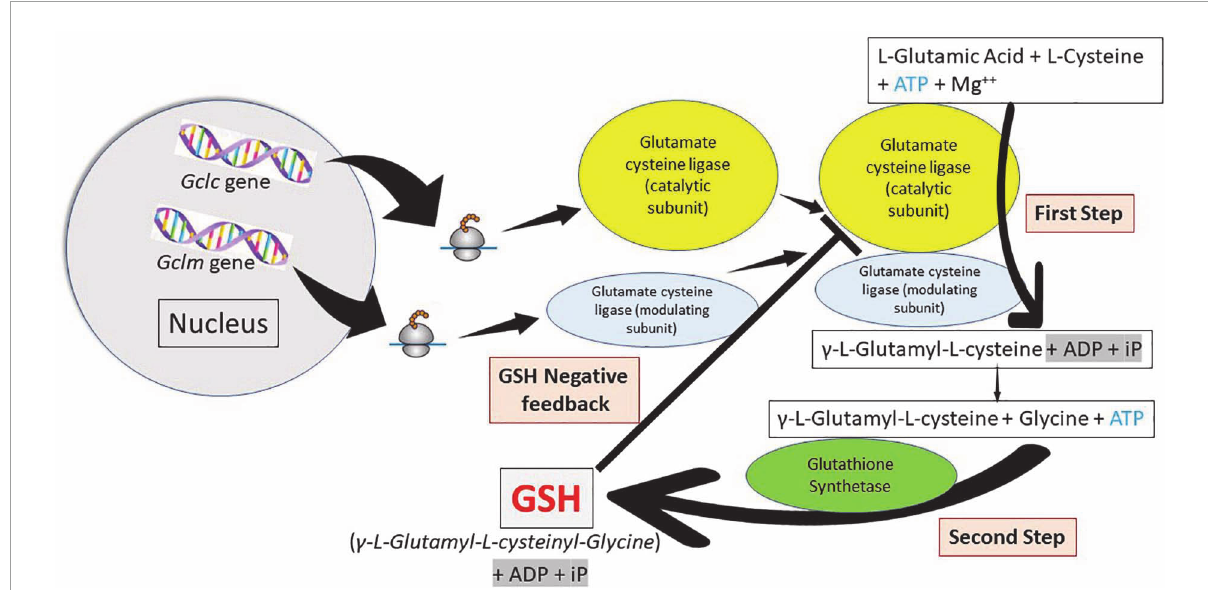
FIGURE3 Glutathione synthesis: A two-step pathway. Homeostasis of cellular glutathione. Synthesis and regulation of the cell concentrations. Glutamate cysteine ligase ( γ -glutamyl cysteine synthetase) constitute the first step in the synthesis of glutathione (GSH) forming γ -L-glutamyl-L-cysteine using adenosine triphosphate (ATP). Glutathione synthetase constitute the second step forming GSH, also using ATP. Cellular GSH concentration regulates the function of glutamate cysteine